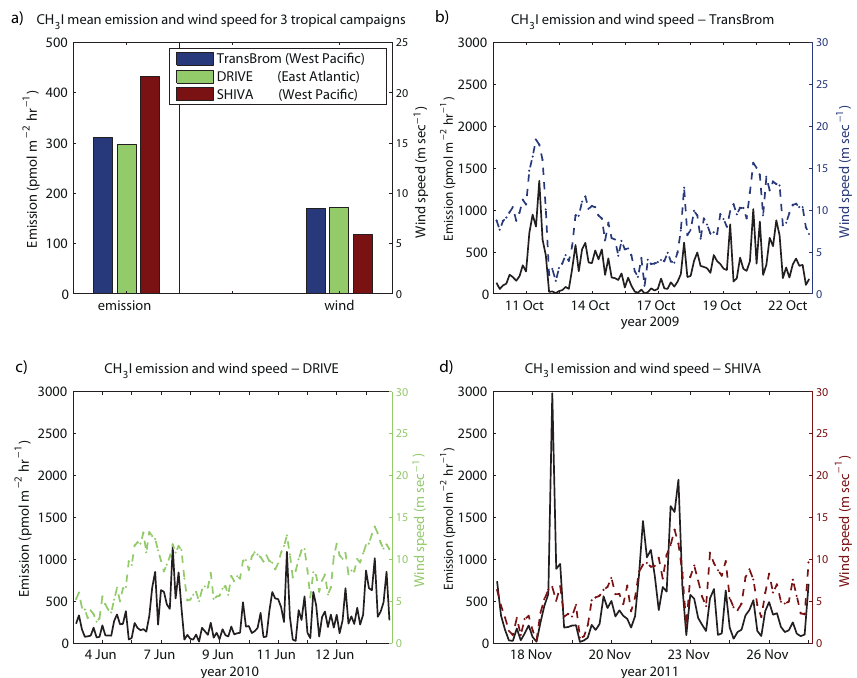
Fig. 2. Campaign-averaged CH 3 I emissions and wind speed are shown for three tropical campaigns (a) . CH 3 I emissions (black line), as well as the wind speed (colored line) are displayed as a function of time along the cruise track for TransBrom (b) , DRIVE (c) , and SHIVA (d)